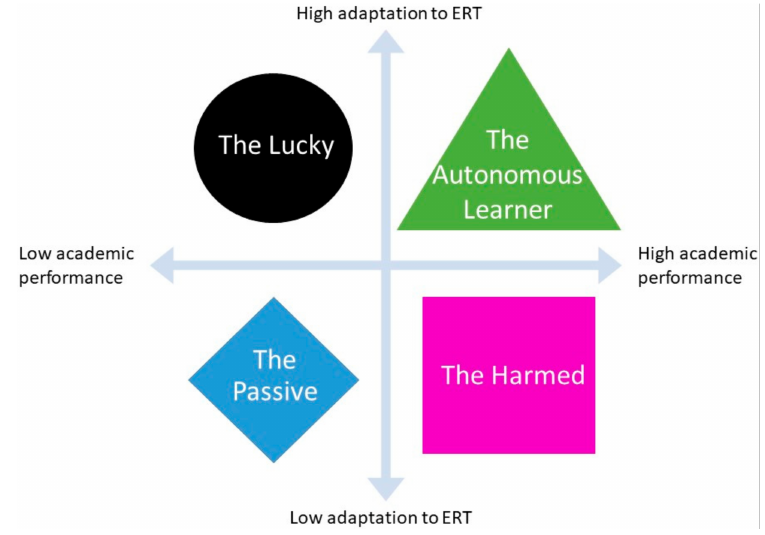
Figure 6. Student profiles